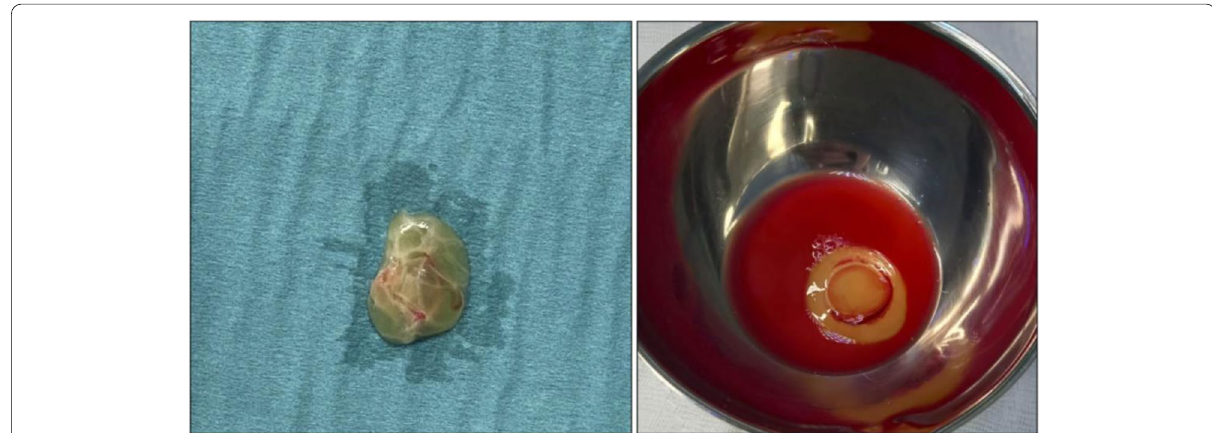
Fig. 2 The autologous platelet-rich fibrin matrix membrane before implantation. The kit provides the membrane set within the platelet rich plasma of the patients (right figure)